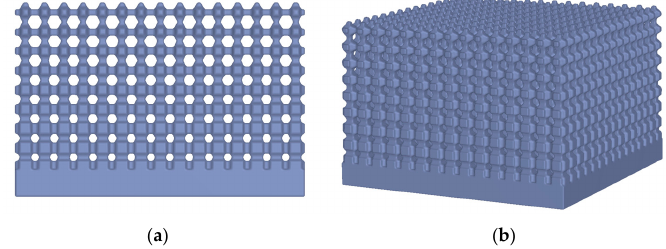
Figure 5. Graded porous structure of a cuboid ( a ) side view; ( b ) perspective view. The pore size increases with increasing component height.